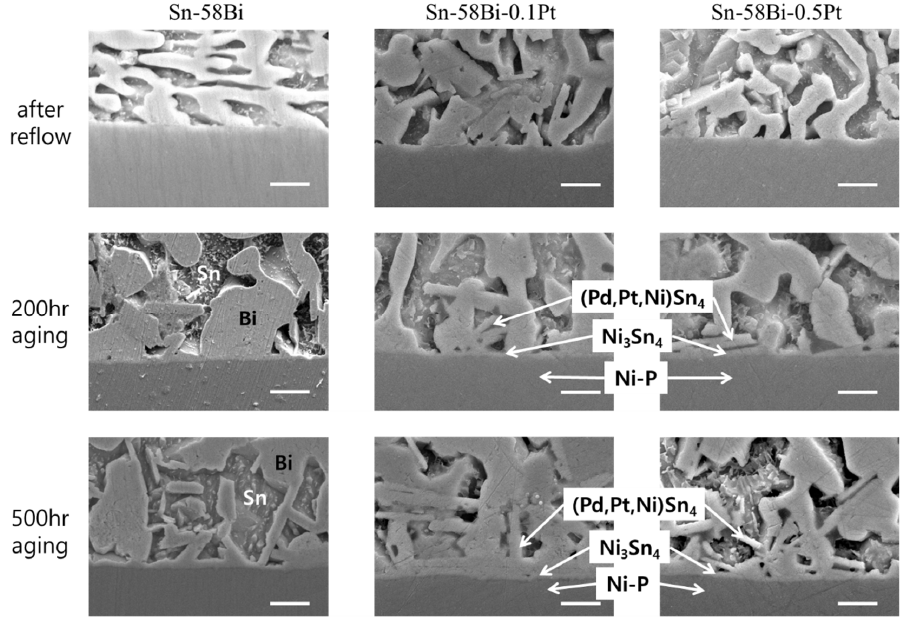
Figure 5. Interfacial microstructures of the Sn-58Bi-xPt/ENEPIG solder joints. (scale bars: 2 μ m). Figure 6 shows the microstructure and EDX line mapping results for the Sn-58Bi- 0.1Pt/ENEPIG interface after 200 h of aging. Here, it was confirmed that a branch-like (Pd,Pt,Ni)Sn 4 IMC was formed on the thin-layer-type Ni 3 Sn 4 IMC. A microstructure with a similar shape was observed at the Sn-58Bi-0.1Pt/ENEPIG interface after 500 h of aging, as shown in Figure 7. Over the remaining Ni-P layer, a Bi map was found on the opposite side of the Sn map, wheres the Pd map was found on the same side as the Sn map. From the analysis results, it can be inferred that the (Pd,Pt,Ni)Sn 4 IMCs are located at the over- lapping positions of the Pd and Sn maps. Therefore, even after 500 h of aging with ENE- PIG, a stable interfacial microstructure was maintained, contrary to the microstructural degradation found in the Sn-58Bi-0.1Pt/ENIG interface after 500 h of aging. Figure 6. EDX elemental analysis of the Sn-58Bi-0.1Pt/ENEPIG interface after 200 h of aging.